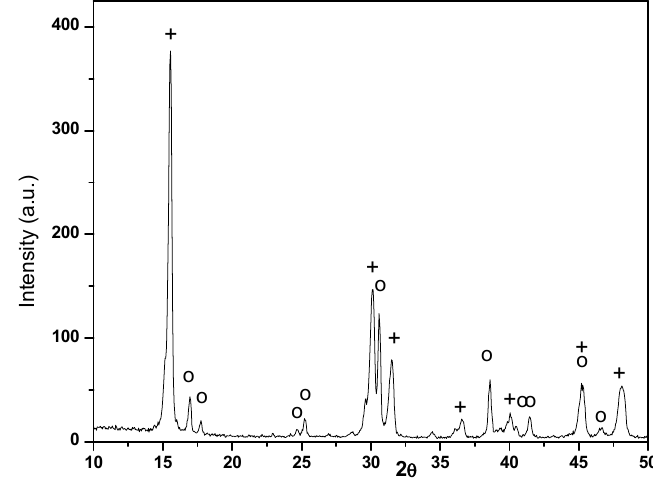
Figure 4. Diffraction pattern of AF 2 sample: ( + ) Al 2 [(OH) x F (1-x) ] 6 (H 2 O) y COD 1000086 (63.4 wt %); ( o ) Al 3 F 14 Na 5 ICSD 26419 (36.6 wt %).